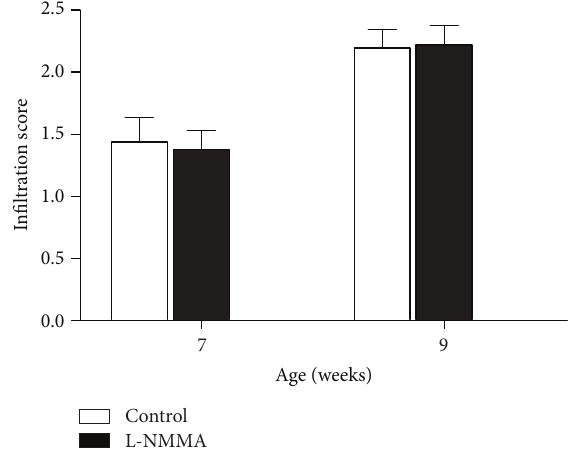
Figure 8: Infiltration scores were determined in Harris’ H&E stained pancreatic sections of BB rats between 7 and 9 weeks of age treated with vehicle (white bars) and L-NMMA (black bars). Results are expressed as the means ± SEM of infiltration scores derived from a mean of 5